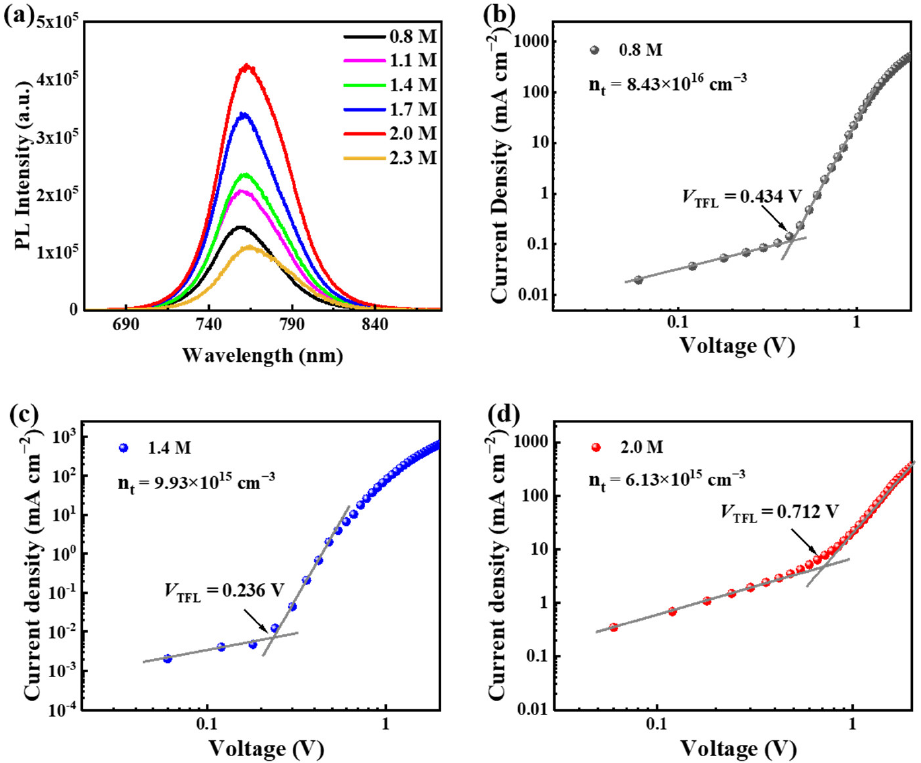
Figure 3. Defect density analysis. ( a ) Steady-state PL spectra of glass/FTO/perovskite. ( b – d ) The space-charge-limited current curves of the electron-only devices with a structure of FTO/TiO 2 /per- ovskite/PCBM/Au.